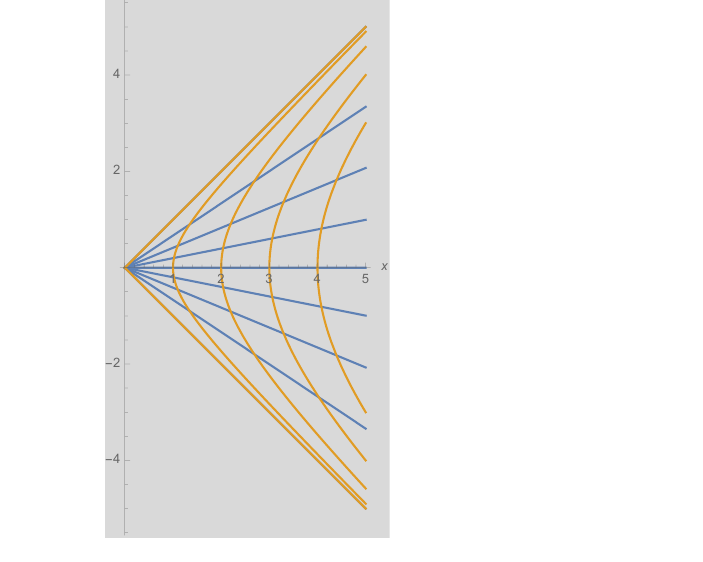
tanh − 1 ( t/x ) = const., constant Rindler α